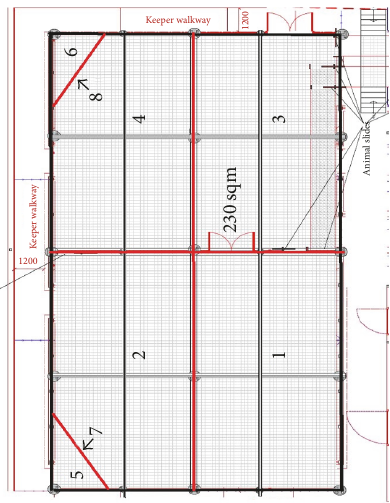
Figure 13: Enclosure map of Whipsnade Zoo.